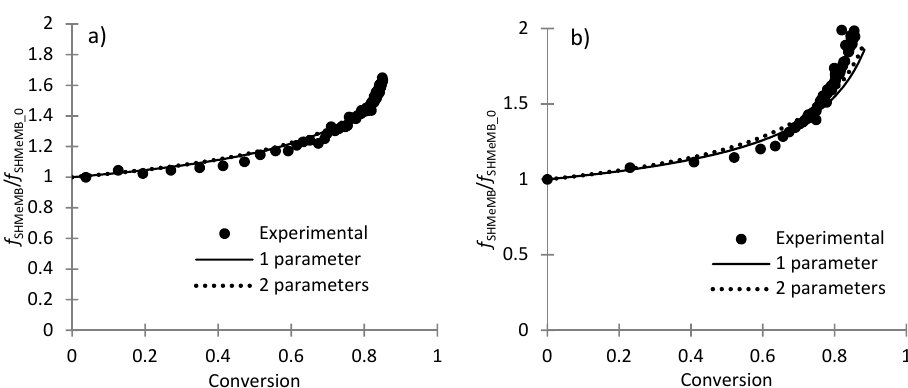
Figure 3. Monomer composition drift for copolymerizations of 3:7 molar ratio of SHMeMB:AM with 15 wt % monomer and 0.5 wt % V-50 at ( a ) 70 and ( b ) 80 °C. The solid line represents parameter estimation with r AM fixed at 0.951 (best-fit value at 50 °C), and the dotted line represents parameter estimation to determine both r AM and r SHMeMB , with values summarized in Table 3.